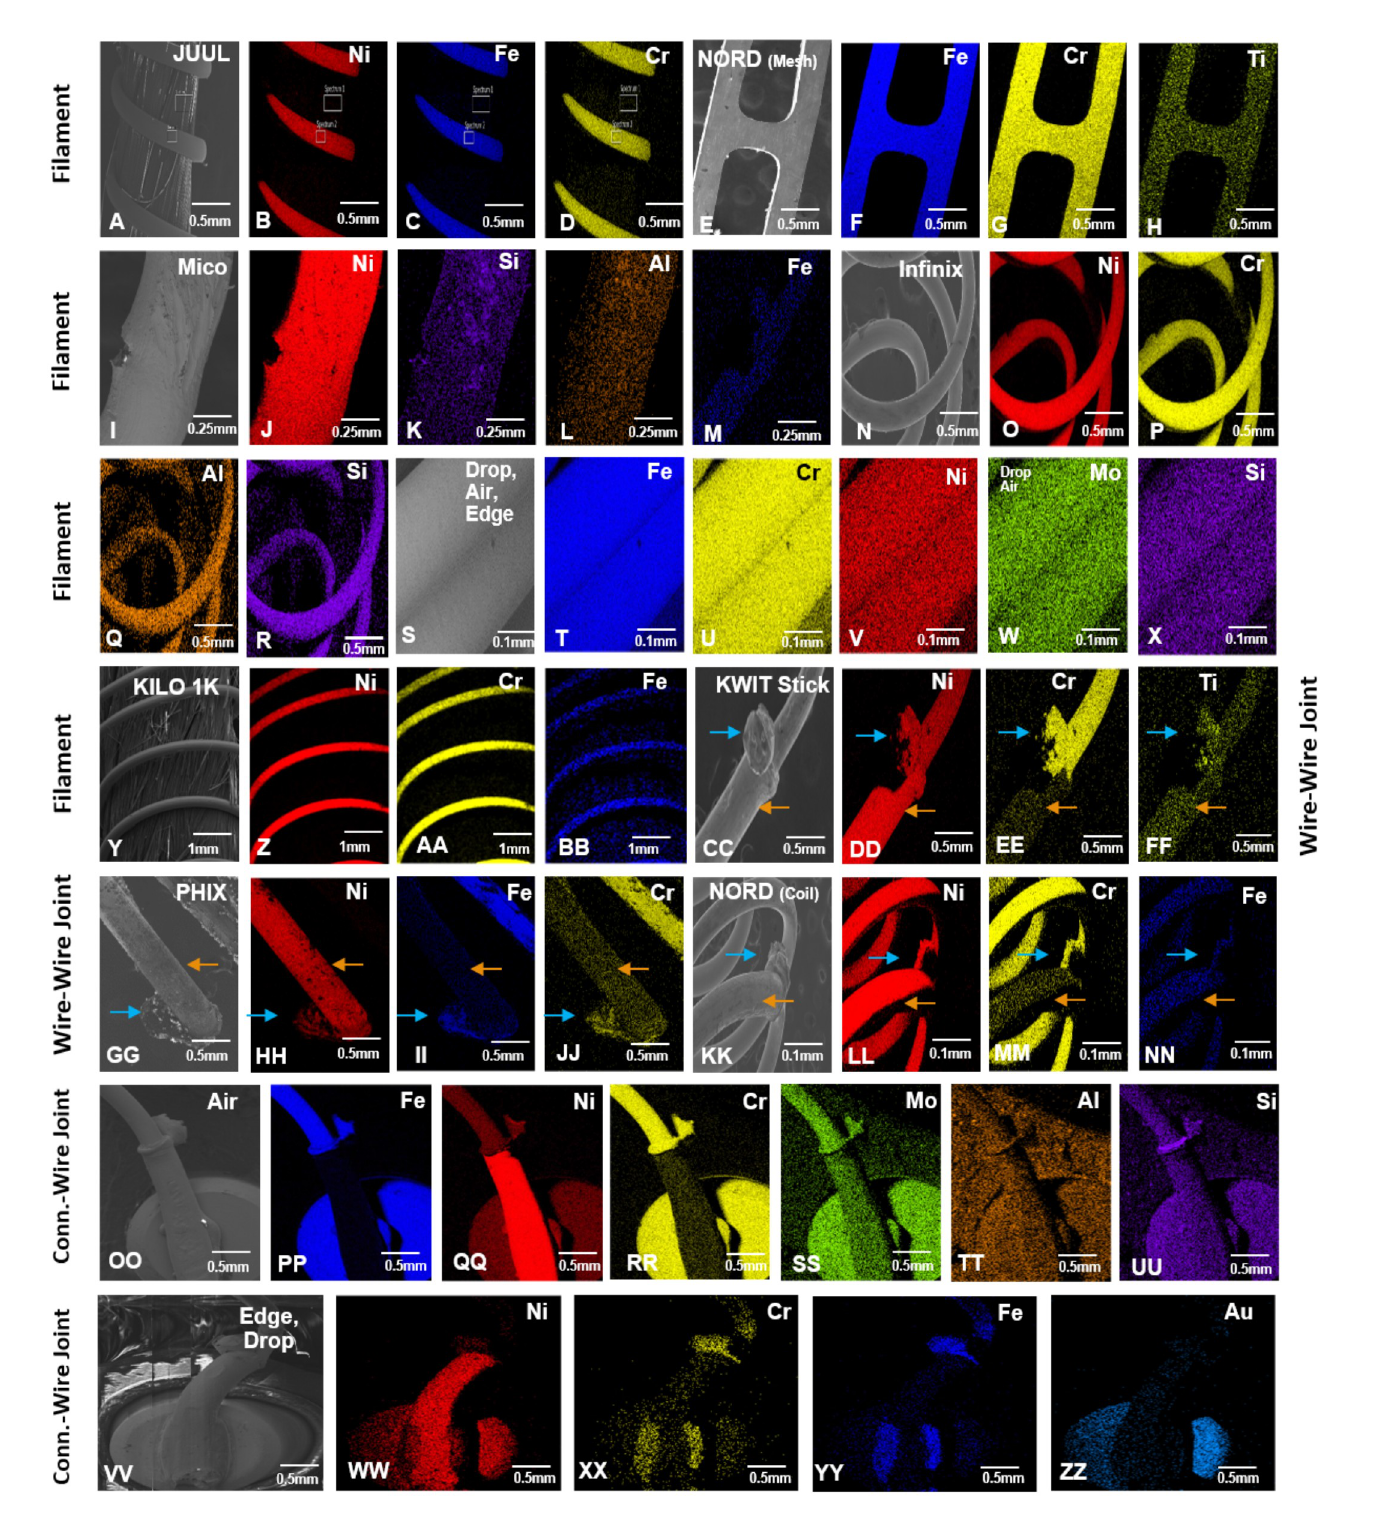
Fig 4. SEM images and EDS elemental maps of the filaments and joints from pod EC atomizers. For filaments, JUUL ™ (A) was made of nickel (B), iron (C), and chromium (D). SMOK NORD (mesh) (E) was made of iron (F), chromium (G), and titanium (H). SMOK Mico (I) was made of nickel (J), silicon (K), aluminum (L),